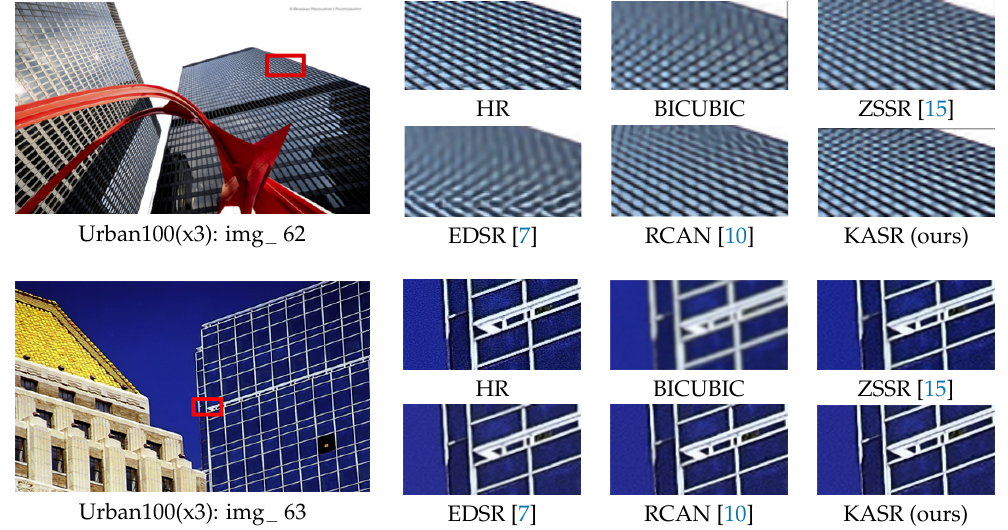
Figure 6. SR results ( × 3) of BICUBIC blur kernel images by different methods